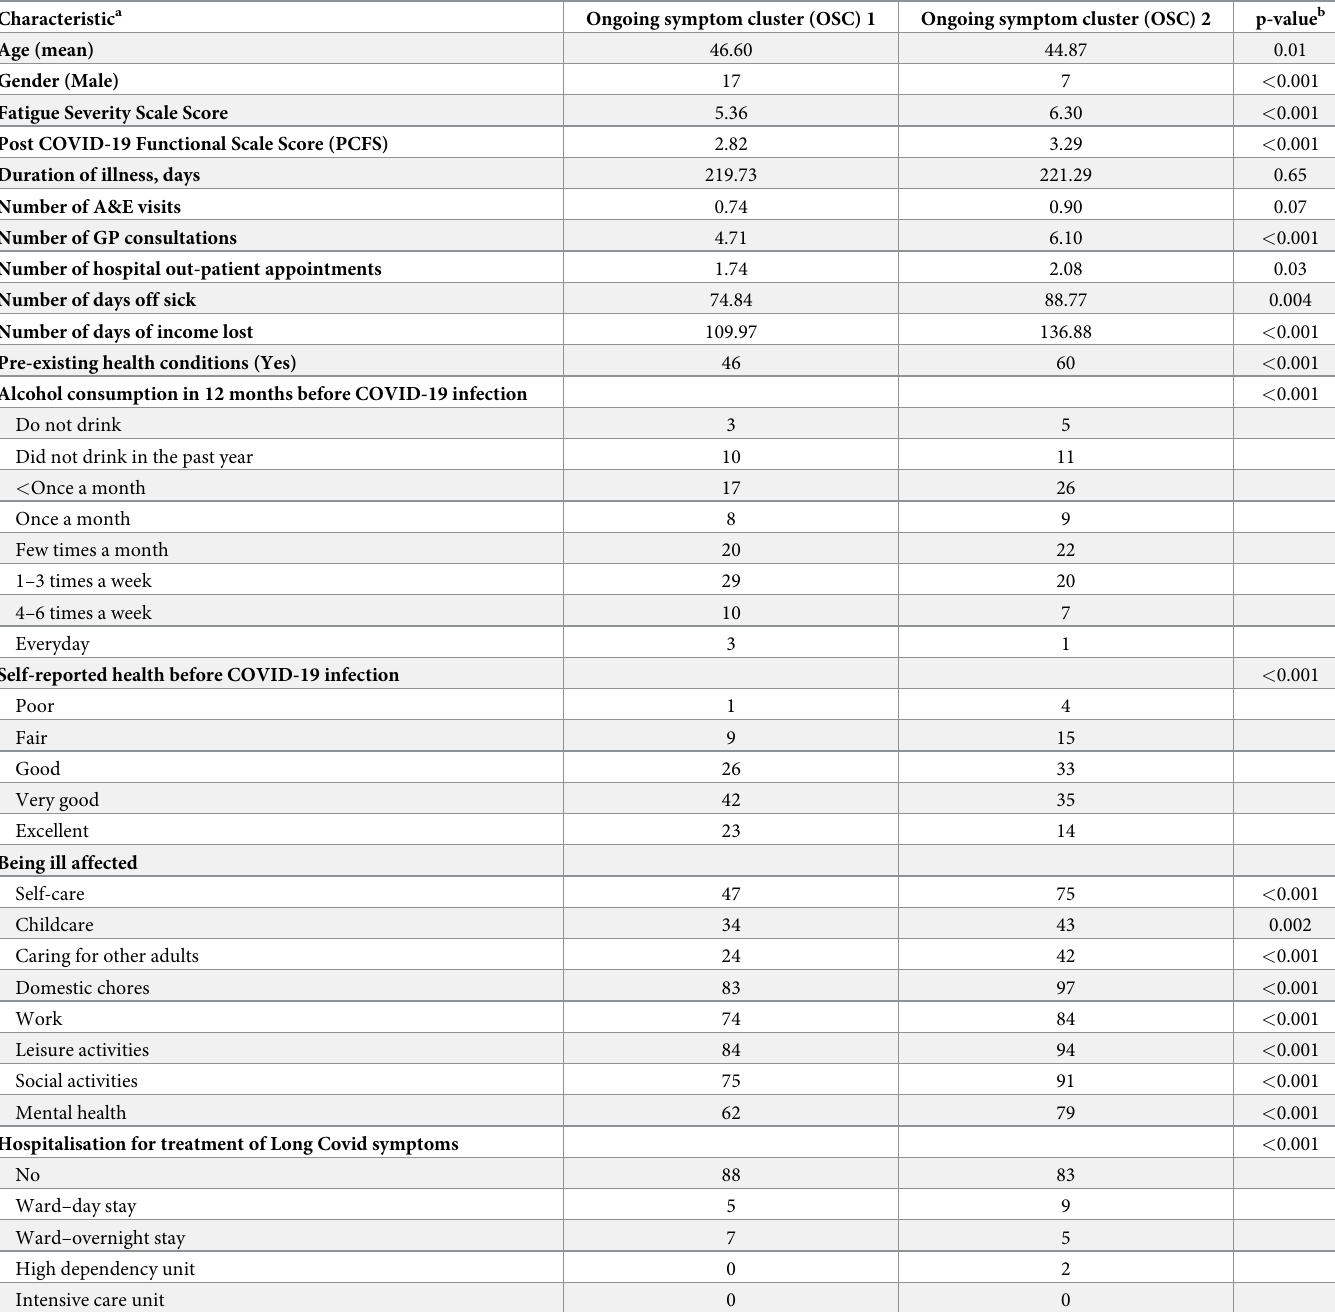
Table 7. Correlates of Ongoing symptom clusters (n =